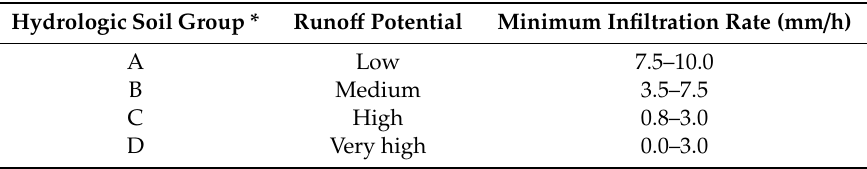
Table 3. Infiltration rate classification of hydrologic soil groups (Özer